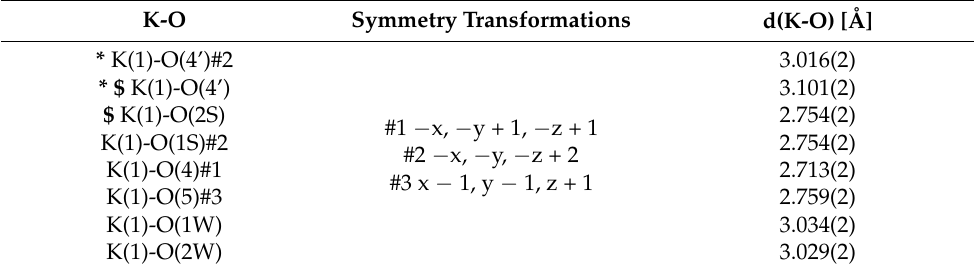
Table 2. The geometry of the cation K + coordination sphere in 1 .